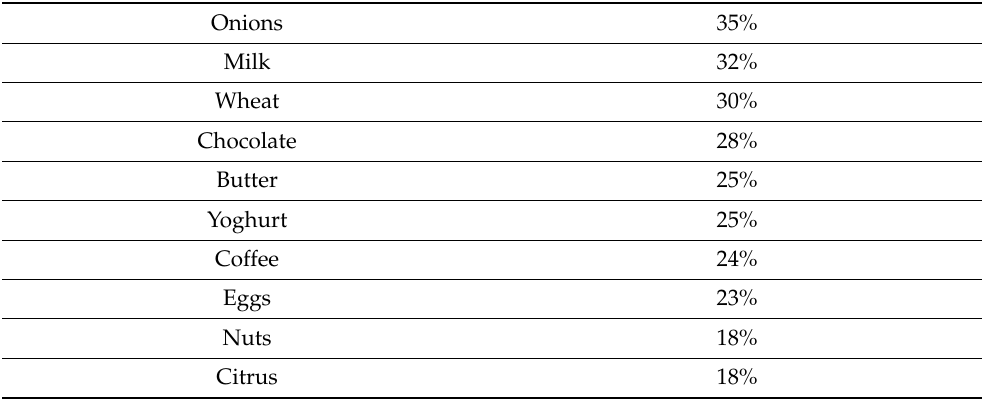
Table 1. Commonly identified foods which caused symptoms